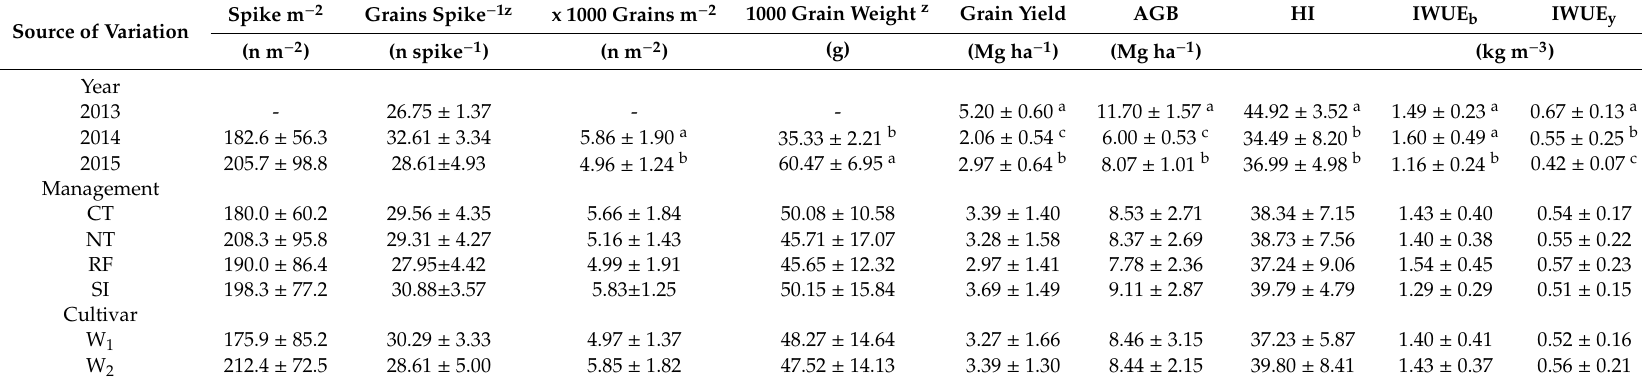
Table 5. Yield and yield components and irrigation water use e ffi ciencies as a ff ected by year, agronomic management, water regime and cultivar under wheat experiment. Source of